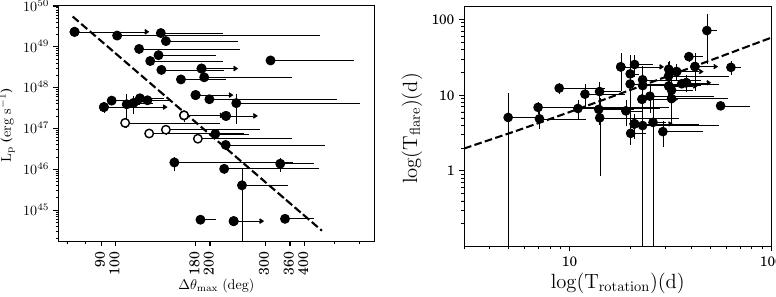
Figure 5. Left panel : γ -ray flare luminosity, L p , vs. EVPA rotation amplitude, ∆ θ max . Empty circles correspond to blazars with uncertain z. Right panel : characteristic timescale of flares, T flare , vs. duration of rotations, T rotation , in the observer frame Lines show linear fits to the data. Based on data from